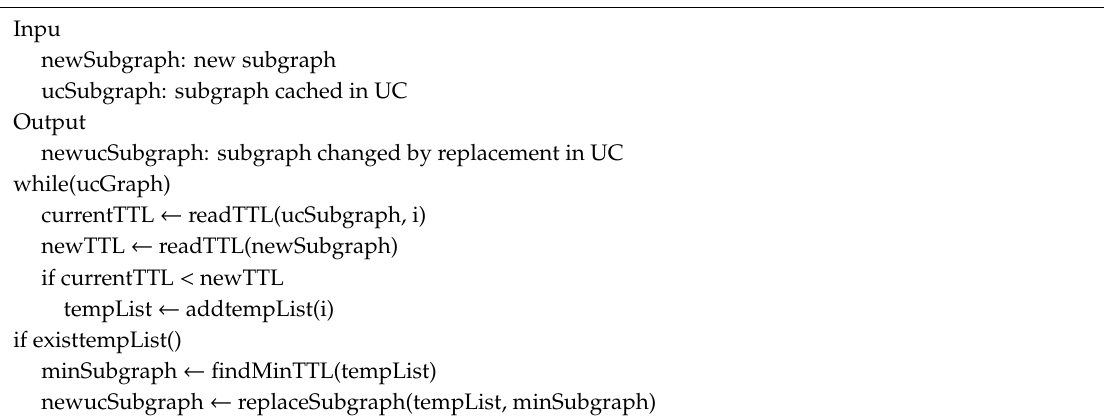
Algorithm 2 replaceUC (newSubgraph,